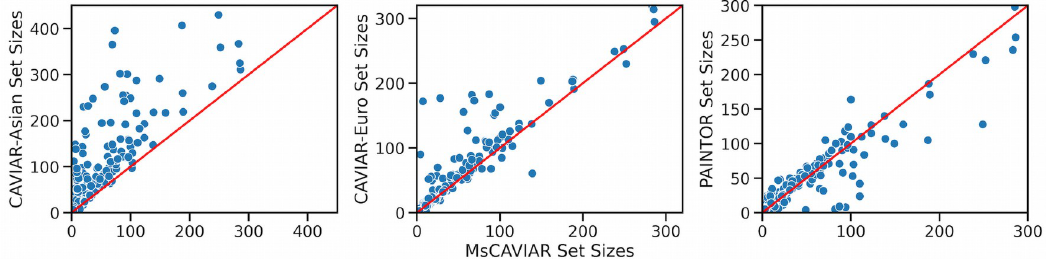
Fig 4. Comparison of methods’ set sizes for each locus in the trans-ethnic HDL analysis. Comparison of the returned causal set sizes of MsCAVIAR when applied to two high-density lipoprotein (HDL) GWAS, White European people from the UK Biobank [23, 24] and Japanese people from Biobank Japan [27, 28], versus trans-ethnic PAINTOR [15] and applying CAVIAR [8] to each population individually. In each scatter plot, each point reflects a specific locus, and the x-coordinate is MsCAVIAR’s returned causal set size, while the y-coordinate is a different method’s causal set size. Diagonal lines representing equal set sizes were plotted for each scatter plot. Points above the line represent loci where the alternate method had a larger causal set size than MsCAVIAR, while points below the line indicate the